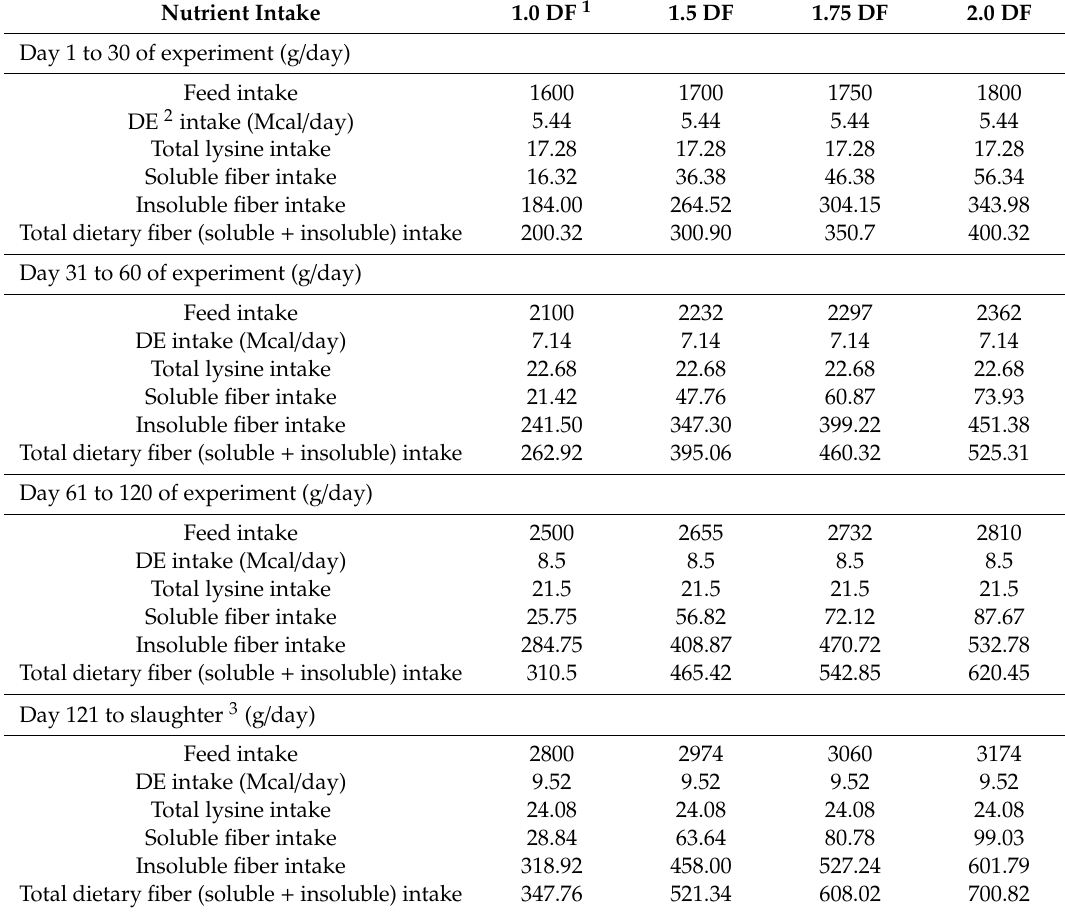
Table 2. The daily nutrient intake of the gilts during di ff erent feeding